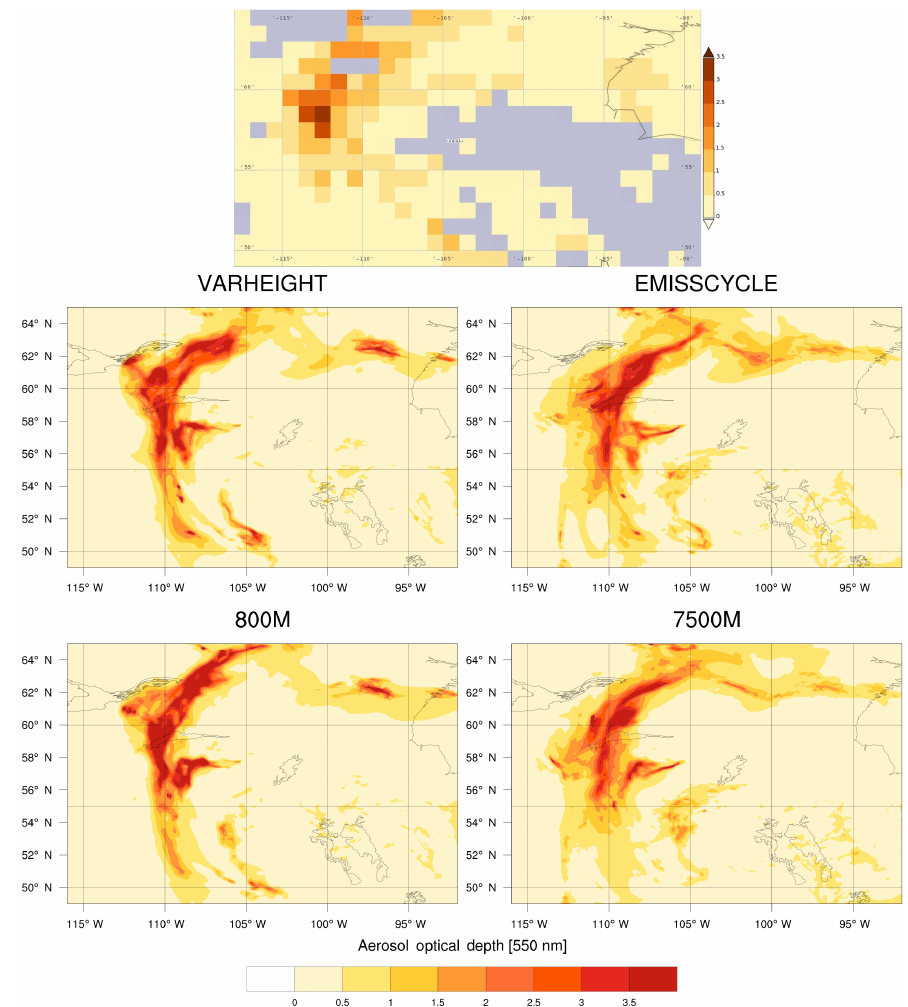
Figure 8. AOD at 550nm averaged over 14–15 July 2010. Top: satellite retrieval from MODIS onboard Terra, below: simulations VARHEIGHT, EMISSIONCYCLE, 800M, and